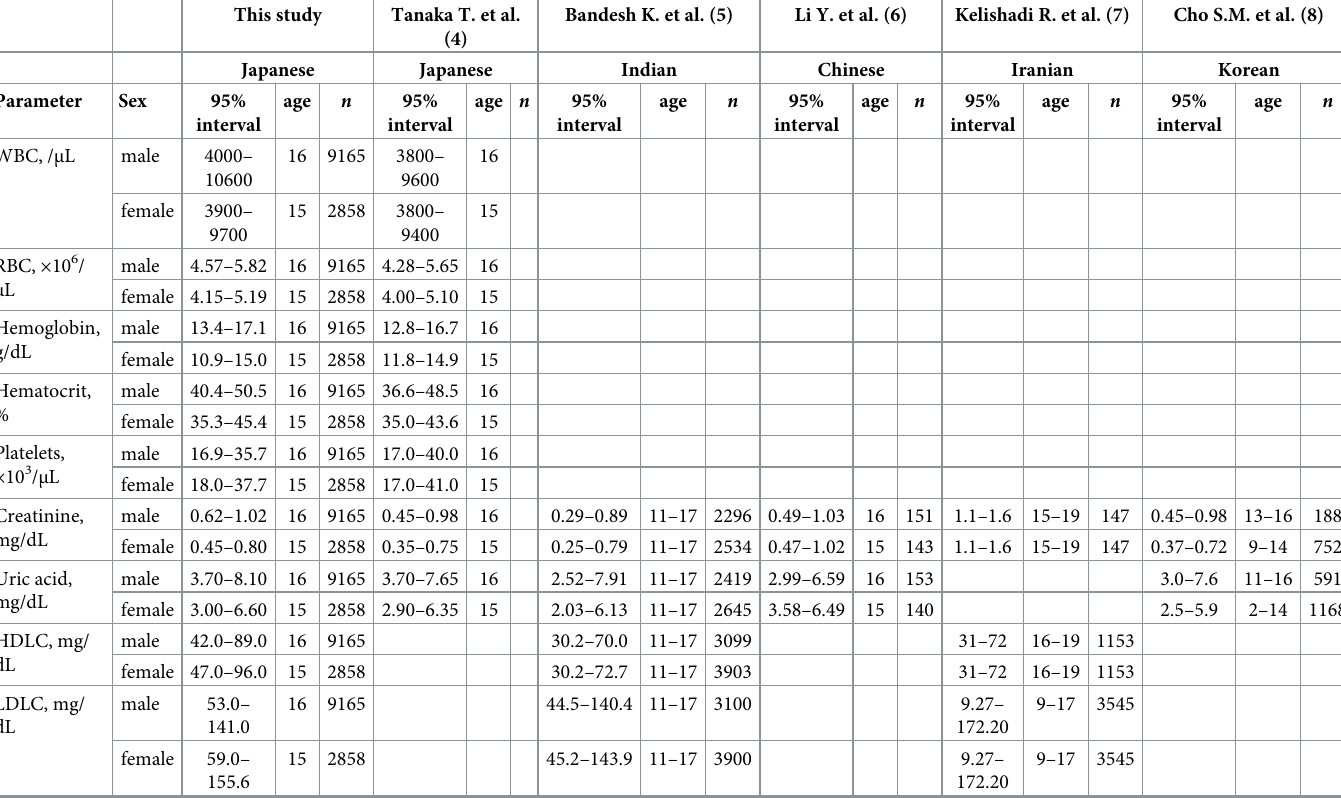
Table 3. Comparison of reference intervals in the current and previous studies.